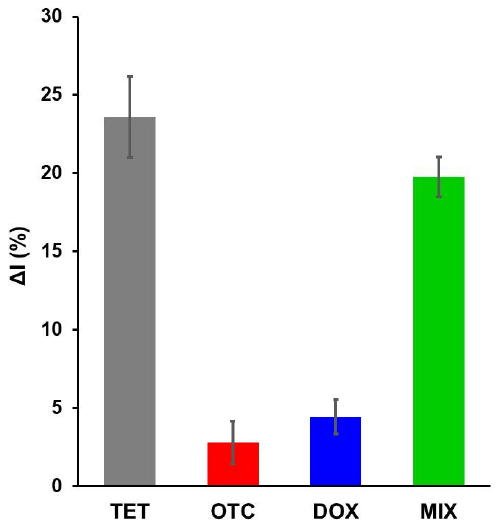
Figure 6. Selectivity of the prepared aptasensor in cow milk spiked with TET, DOX, OTC, and mixture of antibiotics: TET, DOX, and OTC with the same concentration of 0.1 nM (n = 4). Table 3. Comparison of different methods for tetracycline detection in cow milk